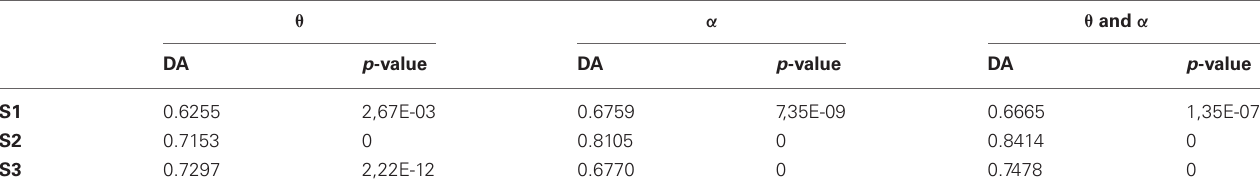
yellow dotted lines show the anatomical definition of the ATL and the TP. (A) and (B) display effects in the theta frequency band in the right and left lateral ATL. (C) Shows theta effects in the inferior ATL. (D–F) Display the corresponding effects for the alpha frequency band. (G) Shows an example of one electrode in the ATL with differences in theta and alpha range power in the two conditions.